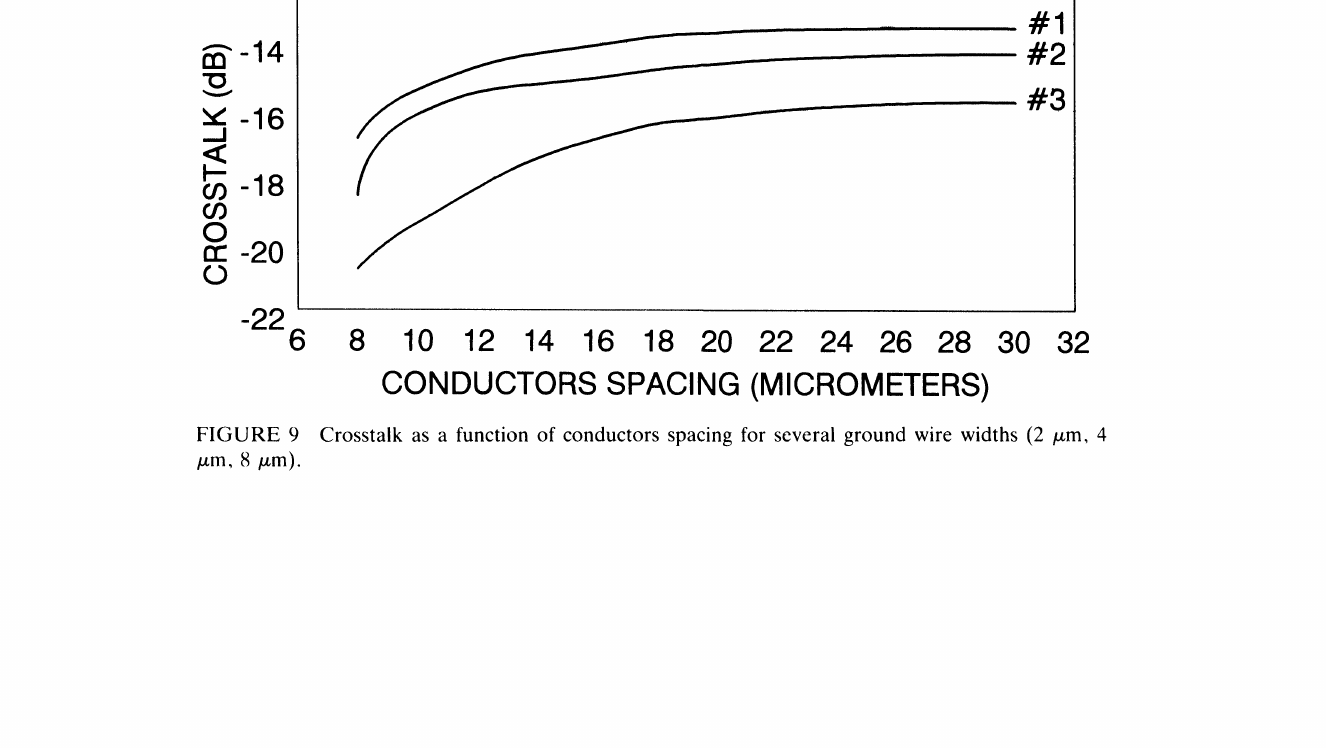
FIGURE 9 Crosstalk as a function of conductors spacin for scvral ground wire widths (2 /m, /zm, 8/zm).